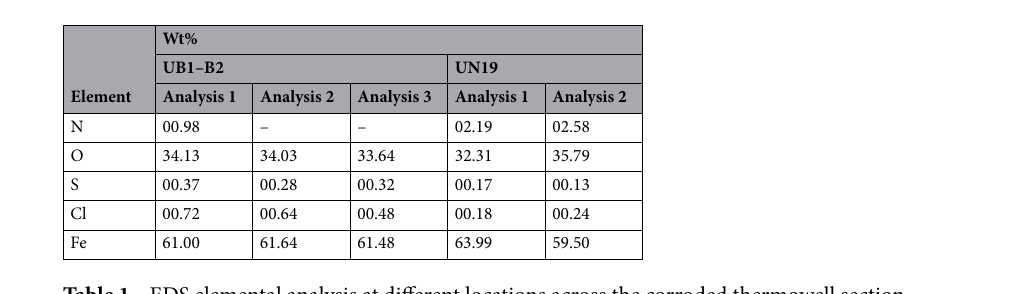
Table 1. EDS elemental analysis at different locations across the corroded thermowell section.